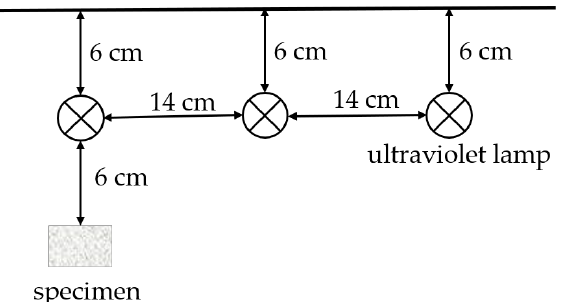
Figure 4. Schematic diagram of the ultraviolet resistance experiment.